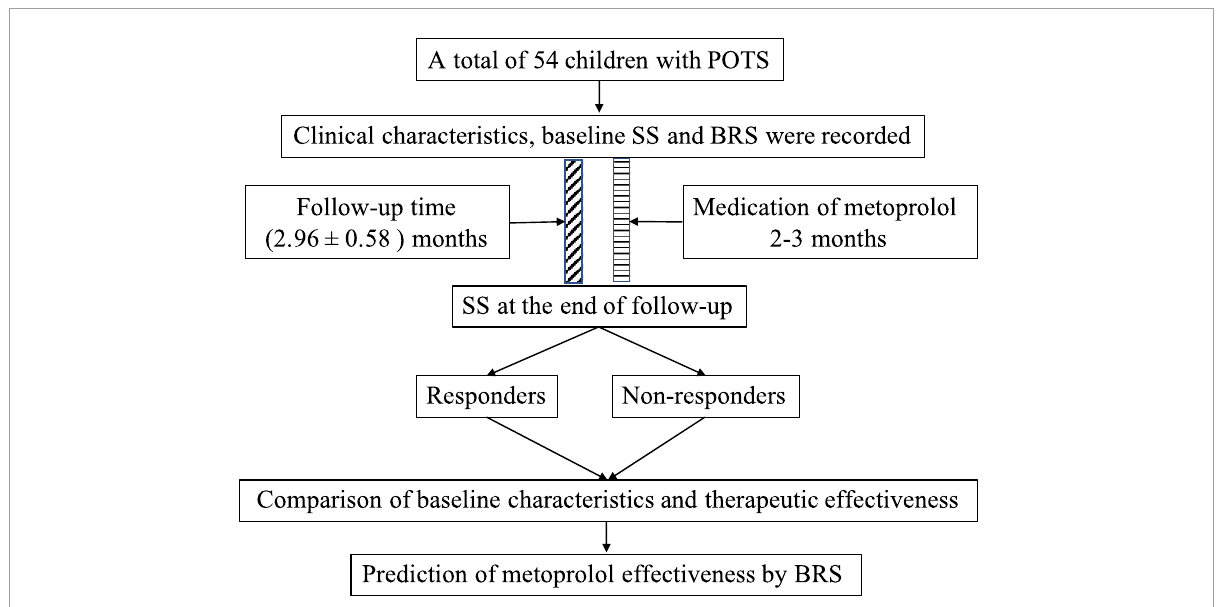
FIGURE1 Flowchart of the study. POTS, postural orthostatic tachycardia syndrome; SS, symptom score; BRS, baroreflex sensitivity.